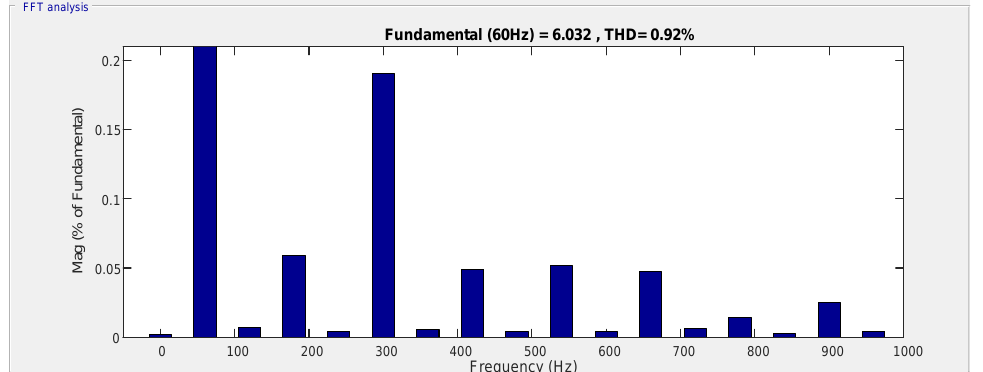
Figure 11. Grid current harmonic spectrum with the L filter.